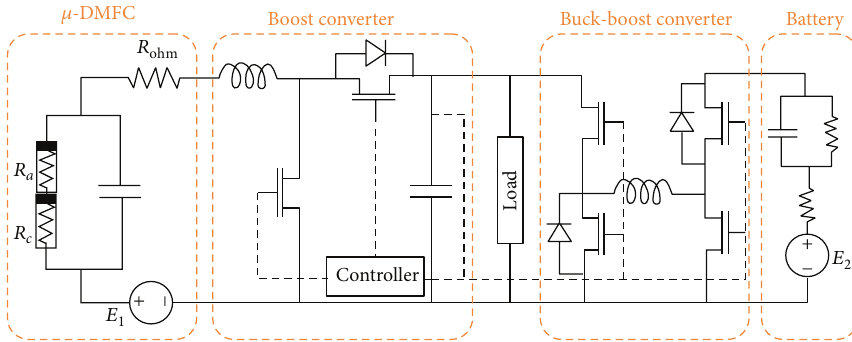
Figure 5: The hybrid power system (small-scale DMFC and Li-ion battery), Alotto et al.